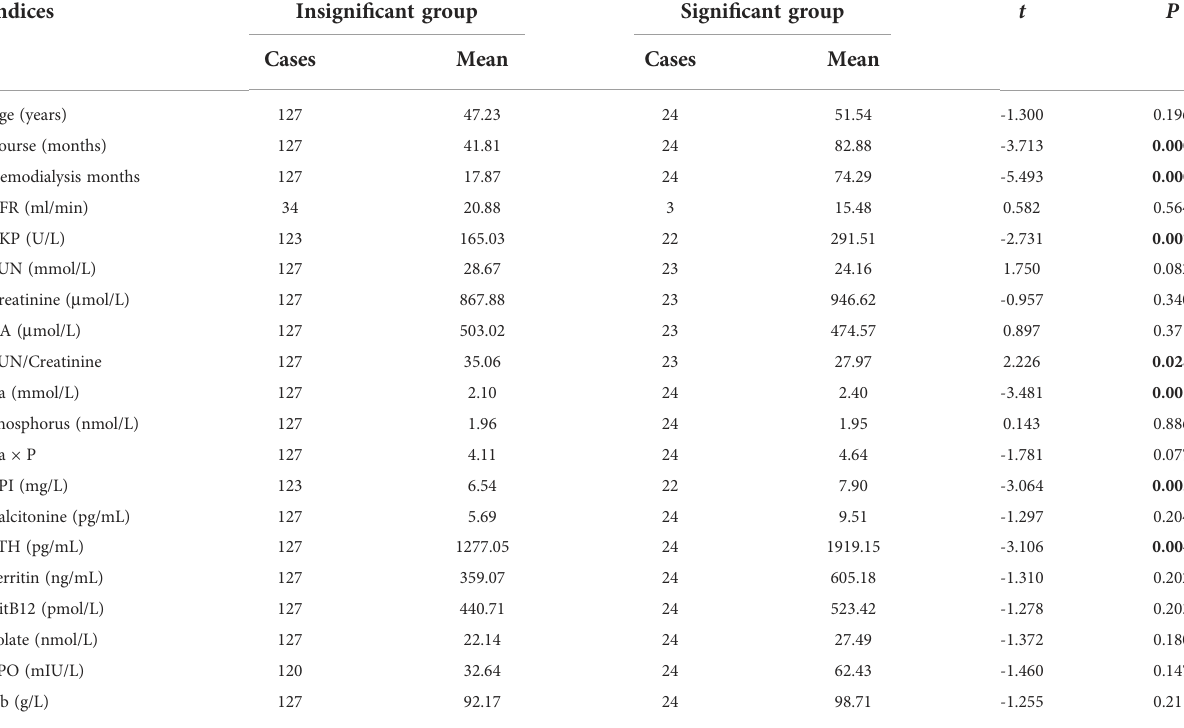
TABLE 5 The comparison of some indices between insigni fi cant and signi fi cant MIBI uptake groups during early phase.